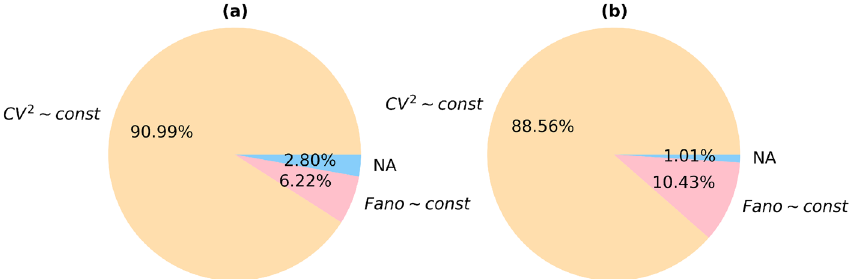
Figure 7. The percentage of aDaVMPs with different normalization types of variability in GSE87571 dataset for males ( a ) and females ( b ): with functional dependence σ 2 ∼ β dependence σ ( F ∼ const , lightblue); aDaVMPs for which the CV group,